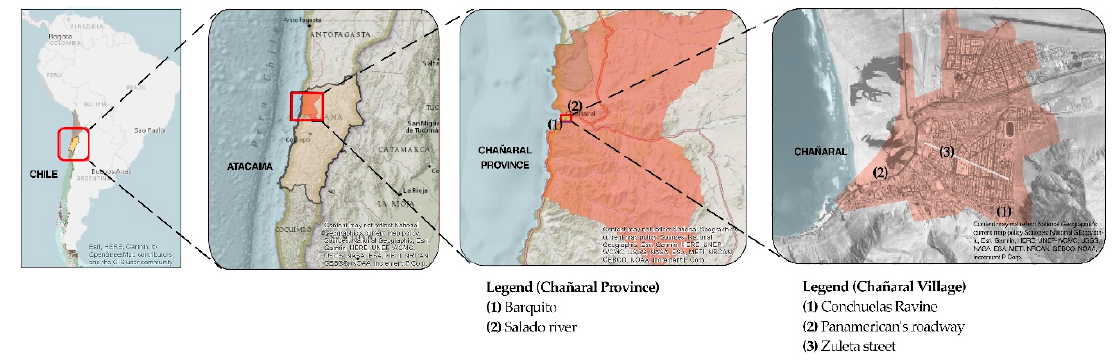
Figure 1. Map of the study area, showing the location of Chile within South America, the Atacama Region, Chañaral Province, and Chañaral. Table 1. List of historical disasters in the city of Chañaral [11–13].